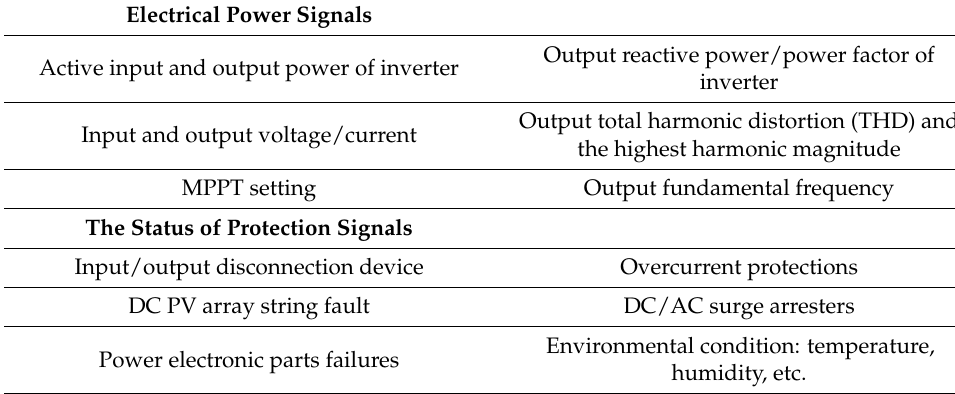
Table 2. The signals necessary to collect and send to the cloud from the inverters of PV and battery